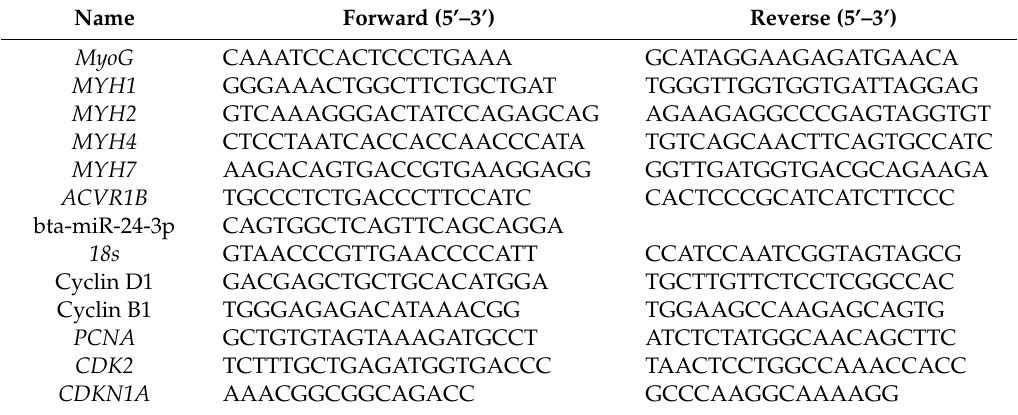
Table 1. Primers used for quantitative real-time PCR